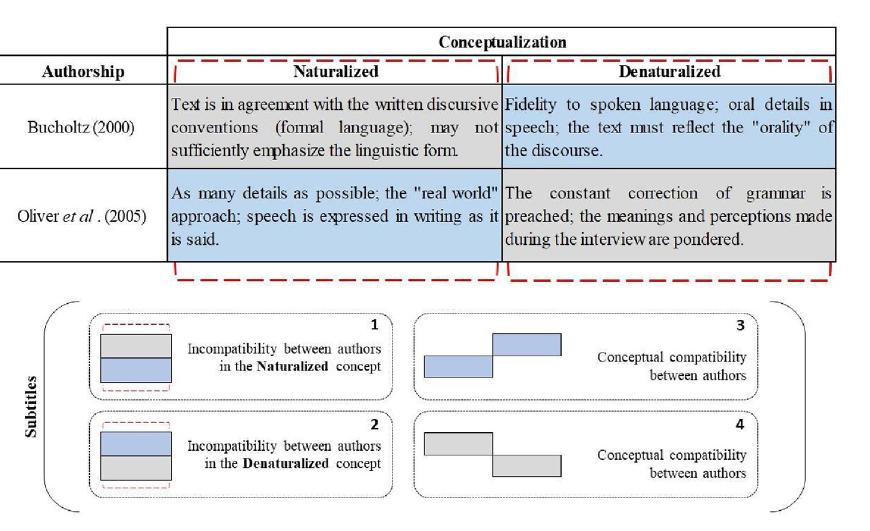
Figure 1. Concepts